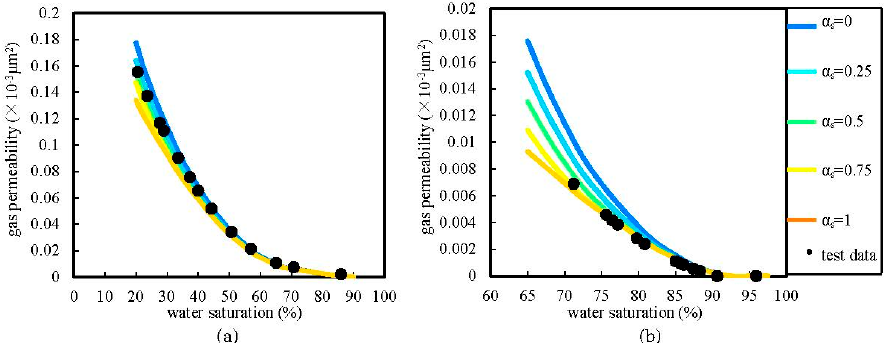
Figure 7. Gas phase permeability curves of tight sandstone cores 24 # and 69 # . ( a ) Gas phase permeability curve core 24 # . ( b ) Gas phase permeability curve core 69 # .